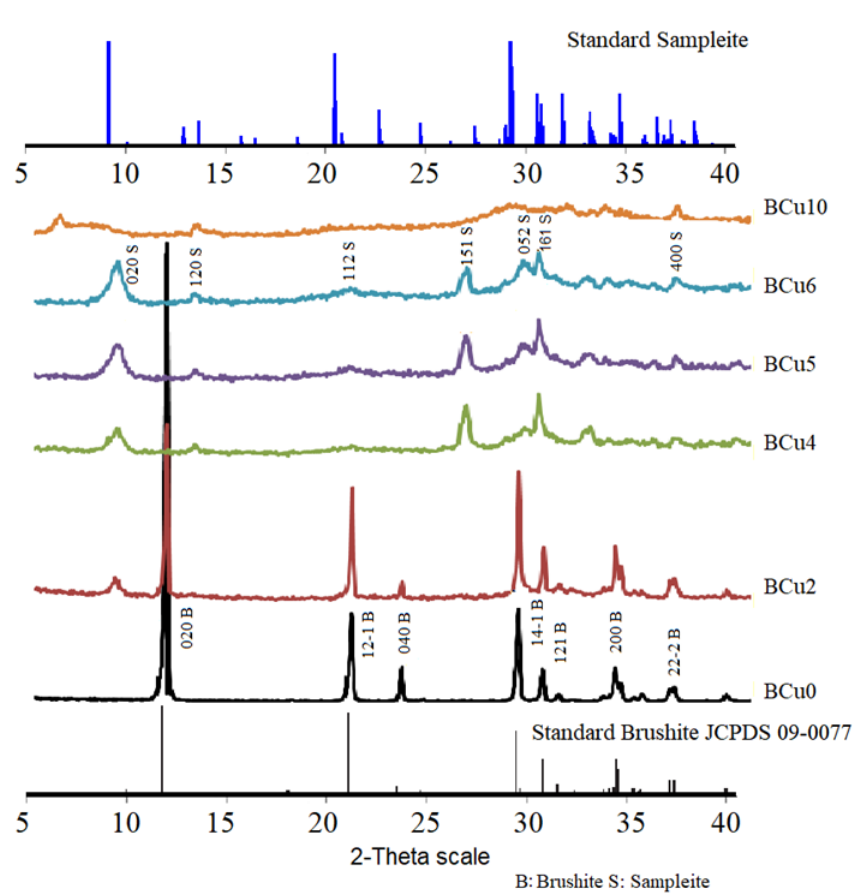
Figure 2. XRD patterns of the calcium–copper phosphates (Table 1).